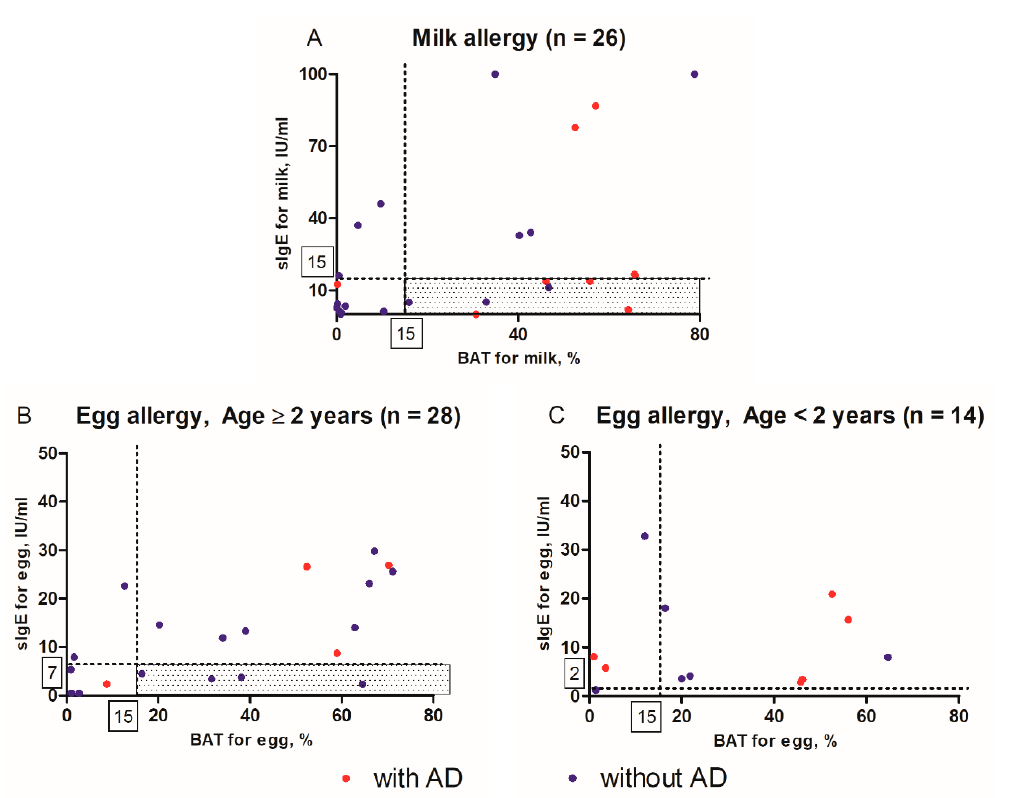
Figure 2. Distributions of specific immunoglobulin E (sIgE) levels and percentages of basophils with the expression of CD63 in ( A ) patients with milk allergy ( n = 26) and ( B ) patients aged ≥ 2 years with egg allergy ( n = 28) and ( C ) patients aged < 2 years with egg allergy ( n = 14). The right lower quadrant (shaded area) represents the area in which a patient with milk or egg allergy tested negative in sIgE and positive in basophil activation test (BAT). Red dots indicate patients with AD, and blue dots indicate without AD. AD, atopic dermatitis; sIgE, specific immunoglobulin E; BAT, basophil activation test.